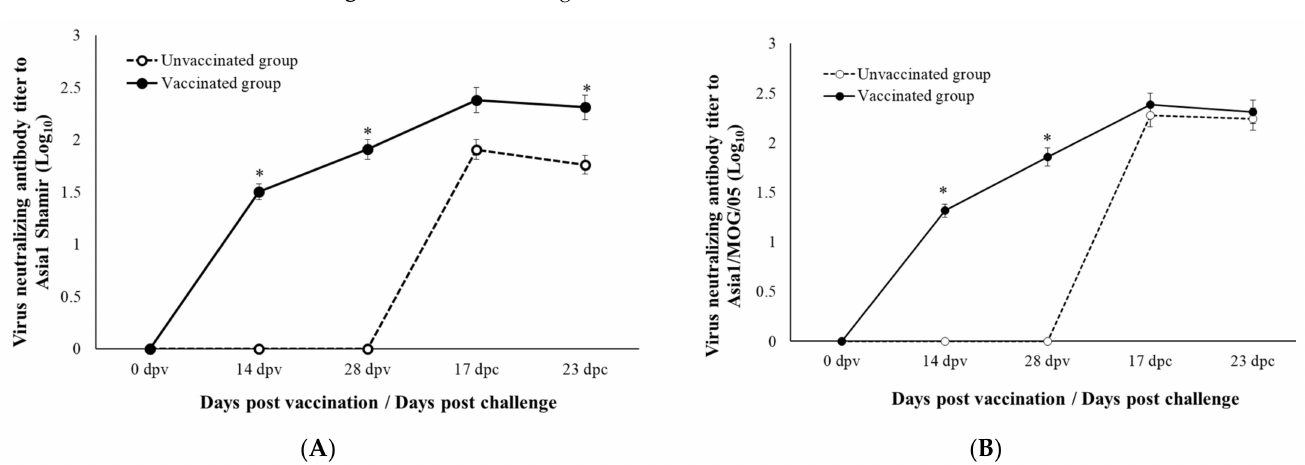
Figure 2. Virus shedding.